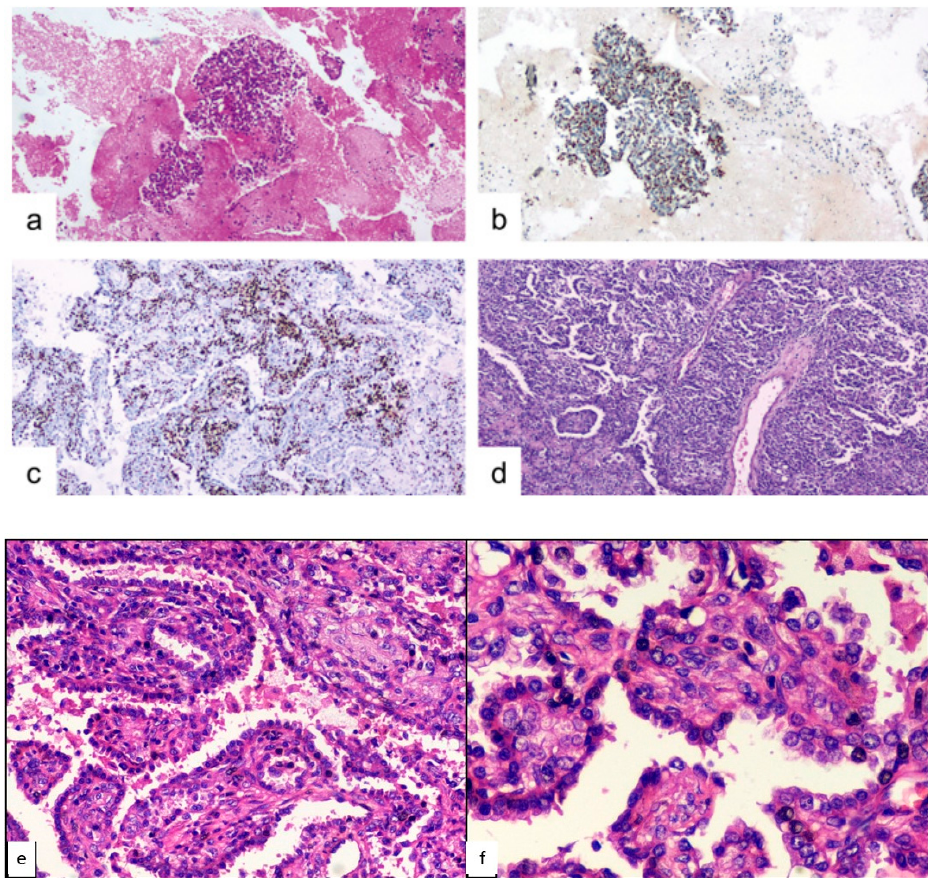
Figure 2. Case 1, microscopic findings. ( a ) cyto-inclusion: spindle cells with focal atypia in the adenomorphic and papillary pattern (hematoxylin-eosin, 10 × ). ( b ) cyto-inclusion: positivity of the neoplastic cells for TTF-1 (10 × ). ( c ) round and spindle cells aggregated in papillae solid nests ex-pressed focal positivity for progesterone-receptor (10 × ). ( d ) histological features of PSP, with varied proportions of sclerotic, solid, papillary and hemorrhagic patterns (hematoxylin-eosin, 10 × ). ( e ) histological detail of the PSP architecture (hematoxylin-eosin, 20 × ). ( f ) histological detail of the PSP architecture (hematoxylin-eosin, 40 × ).